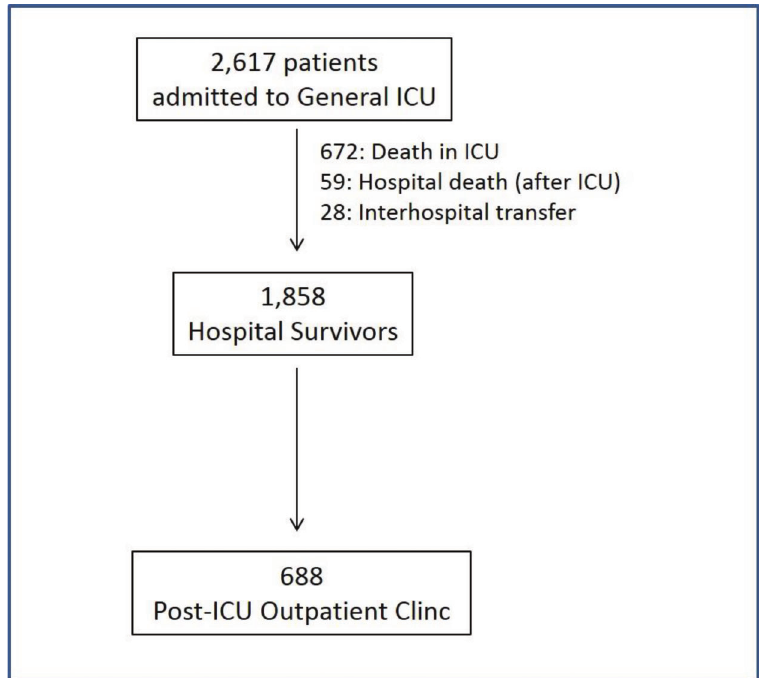
Figure 1 - Patient flow. ICU: Intensive Care